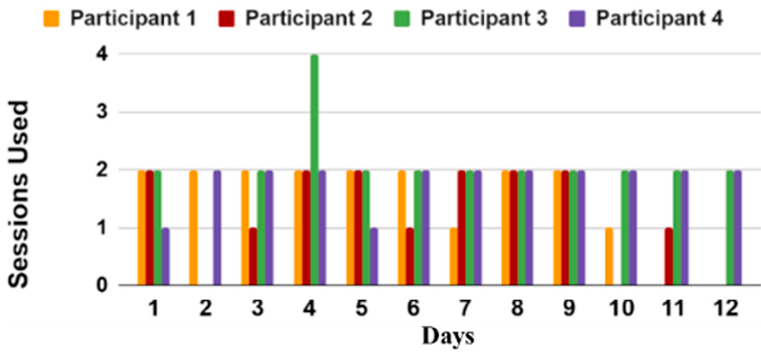
Figure 12. Bar graph representing participant adherence in using iTex system.